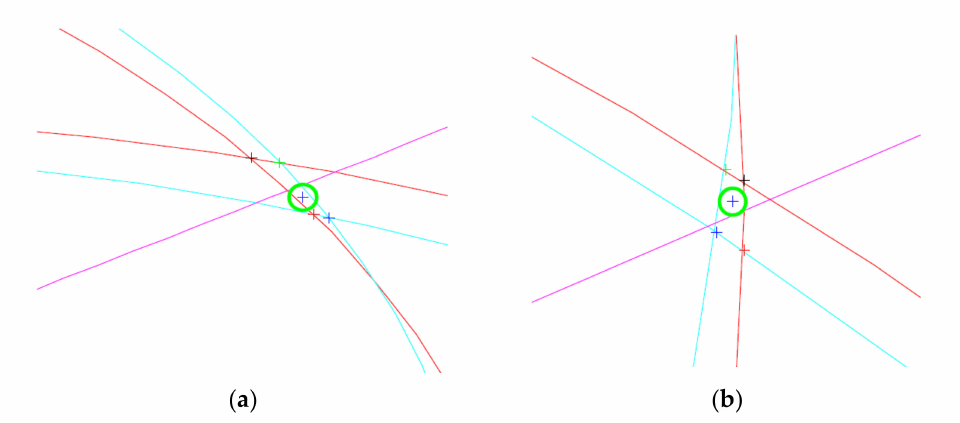
Figure 12. Examples of center of gravity point positions for ( a ) τ = 50 and ( b ) τ = 100. In cases where the lines are marked as line No.1. and line No.2., the line